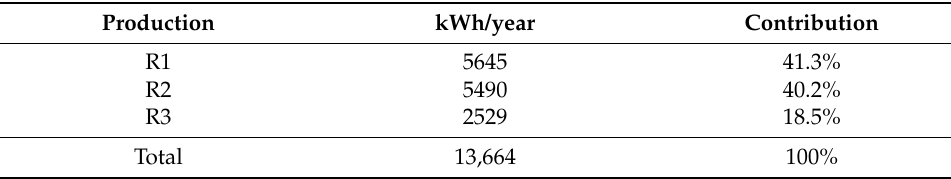
Figure 12. Monthly electricity production of the OSC at 14.2 kWh/day. Table 9. Summary of energy production of the OSC at 14.2 kWh/day.